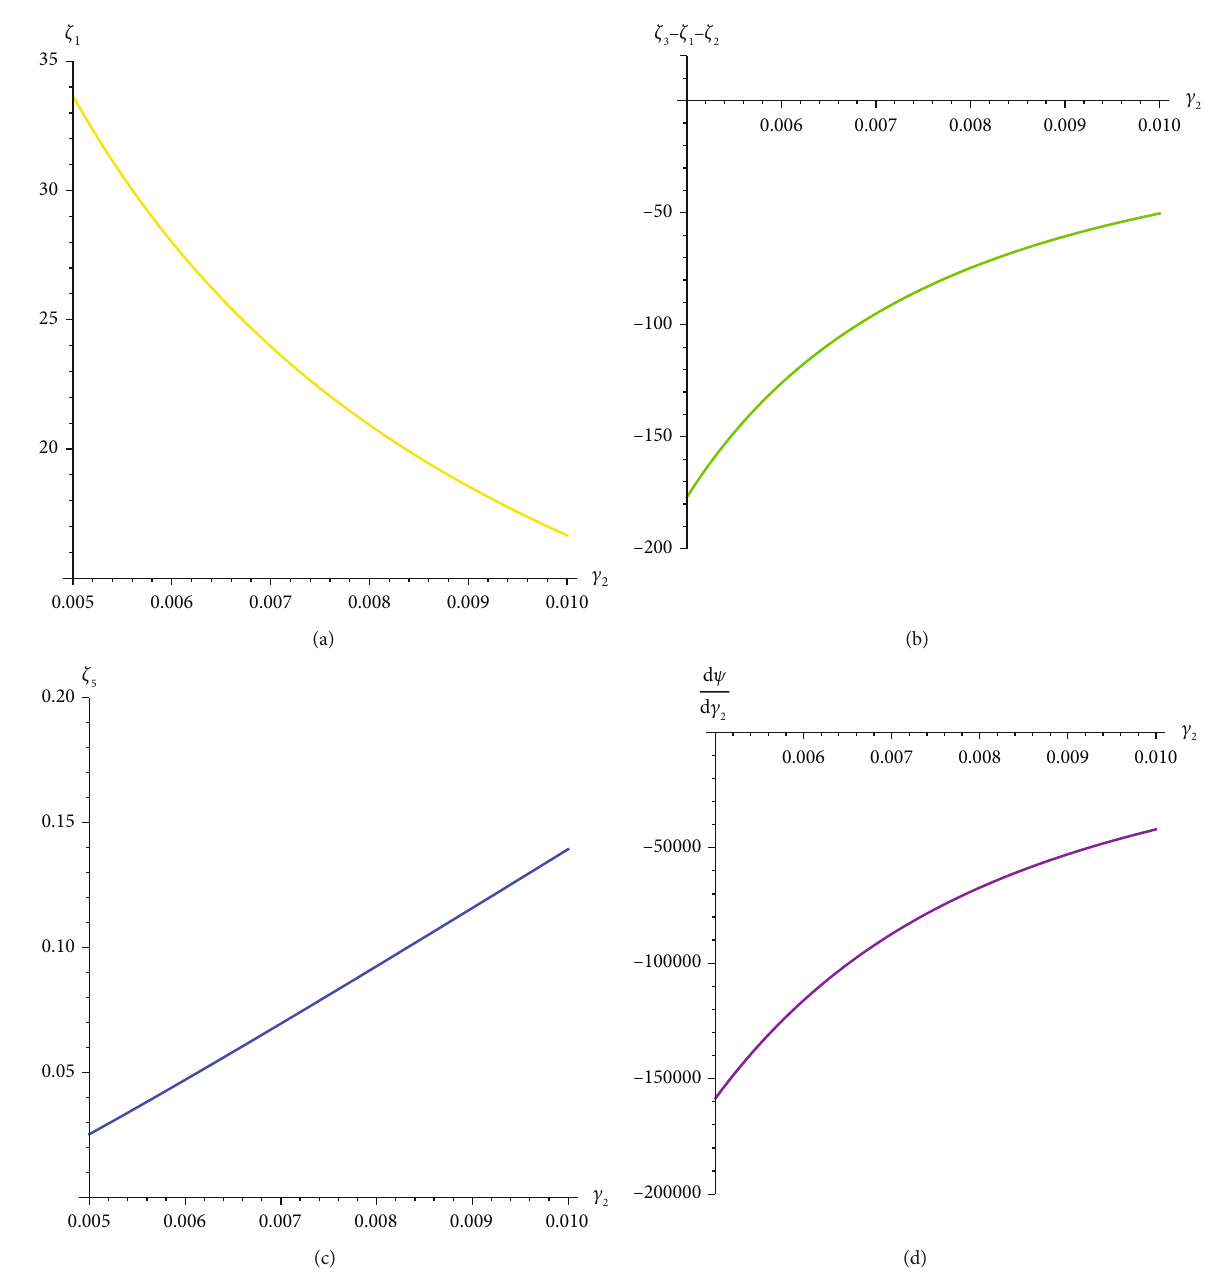
ζ ζ − ζ ζ ζ − ζ ω ; and (d) d Ψ ð γ 1 ; (b) 3 1 2 ; (c) 3 1